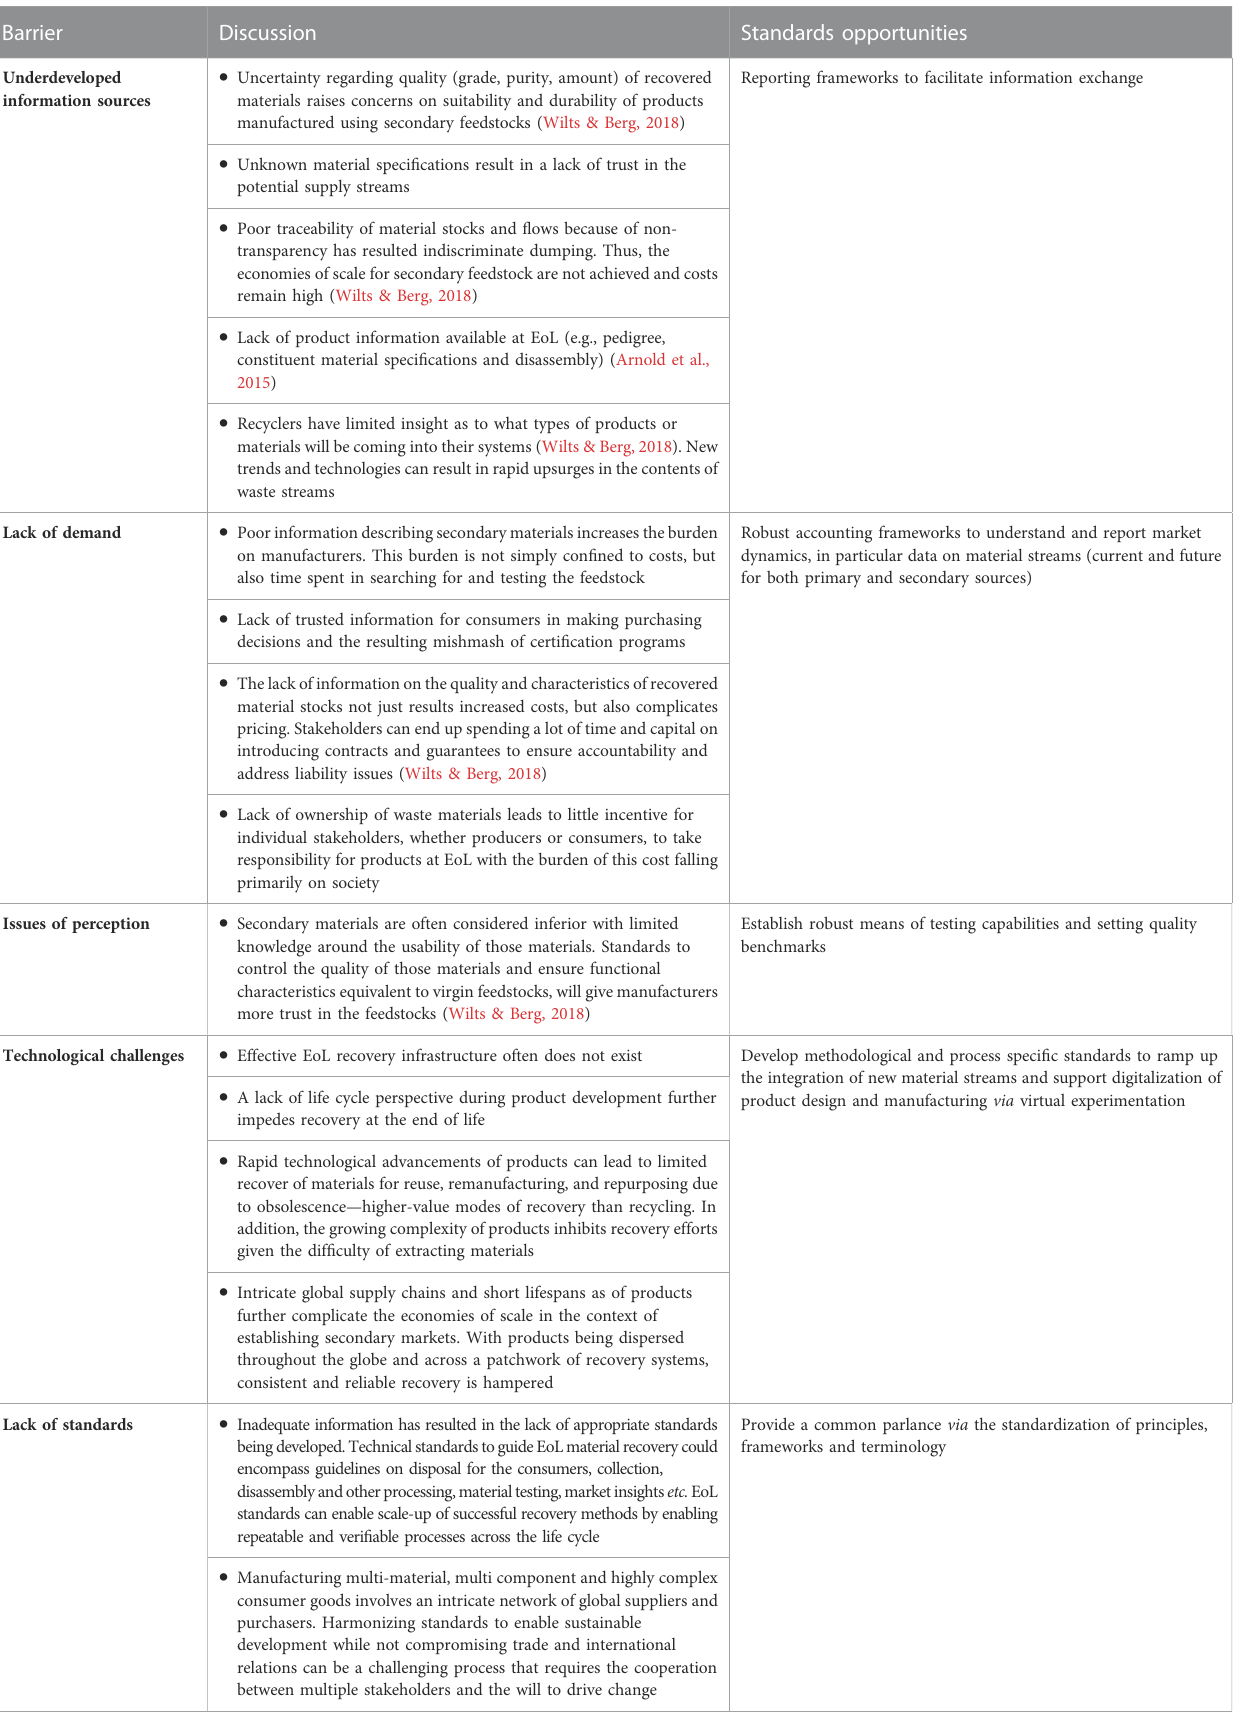
TABLE 1 Barriers to EoL material recovery (Arnold et al., 2015; Wilts & Berg, 2018). Barrier Discussion Standards